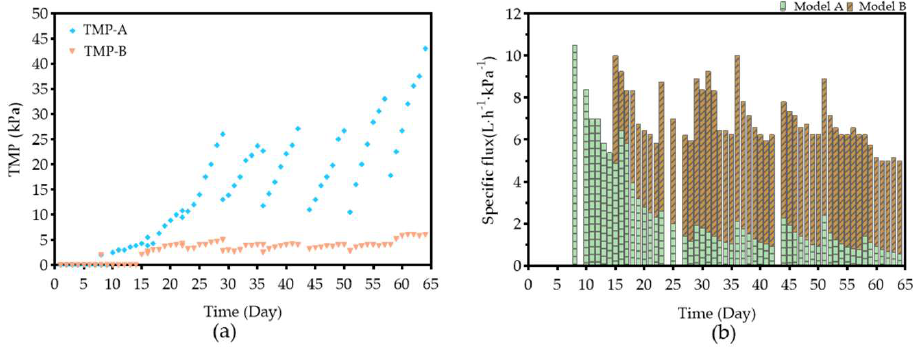
Figure 4. ( a ) The change in TMP with different membrane models in LEP-N-MBR. ( b ) The profile of specific flux under different membrane models in LEP-N-MBR.